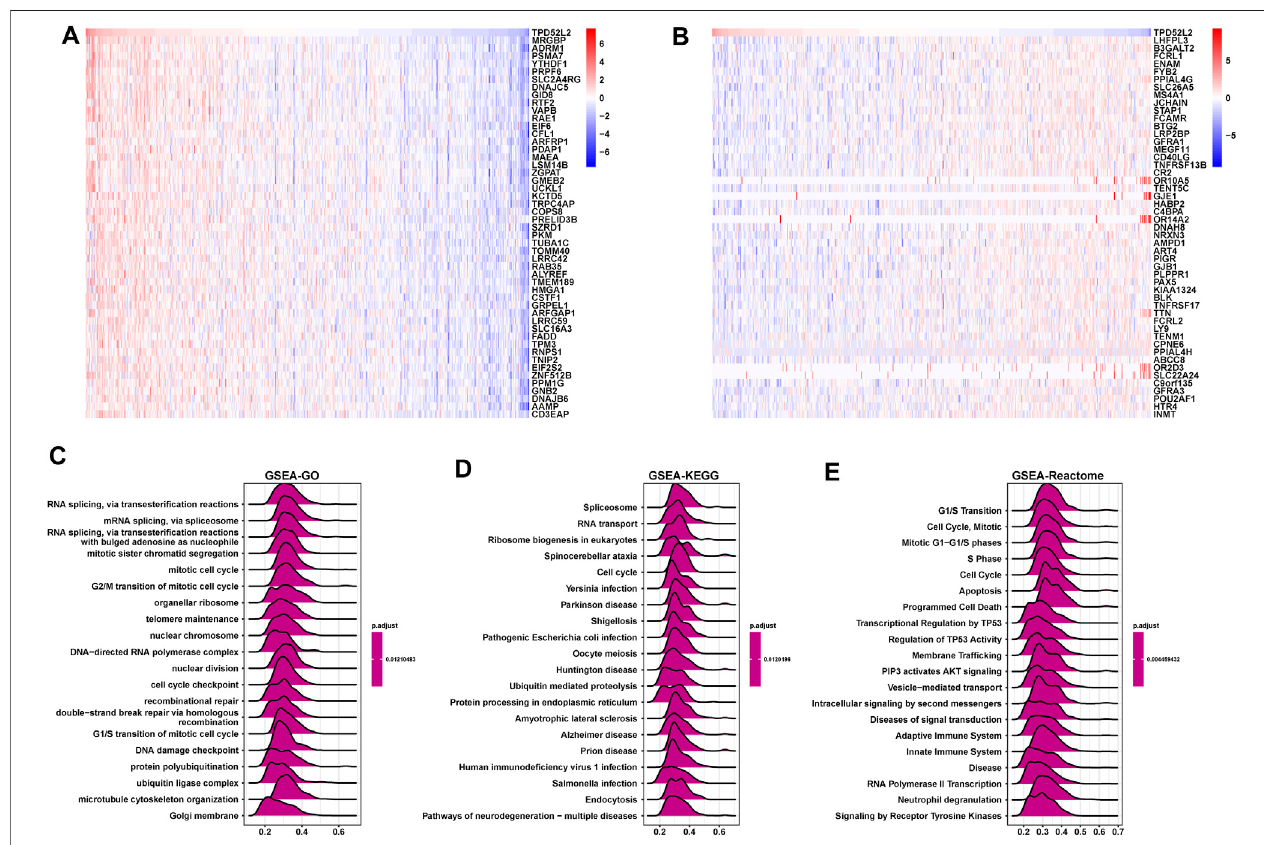
FIGURE6| GSEA ofTPD52L2. (A) Expression oftop50 genespositivelycorrelatedwithTPD52L2 expression inLUAD. (B) Expression oftop 50genesnegatively correlatedwithTPD52L2expressioninLUAD. (C) Thetop20GSEA-GOresultsareshowninLUAD. (D) Thetop20GSEA-KEGGresultsareshowninLUAD. (E) Thetop 20 GSEA-Reactome results are shown in